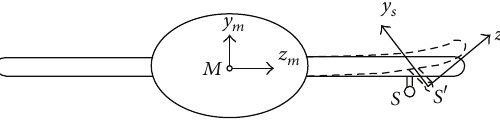
Figure 1: The airborne missile suspended under the